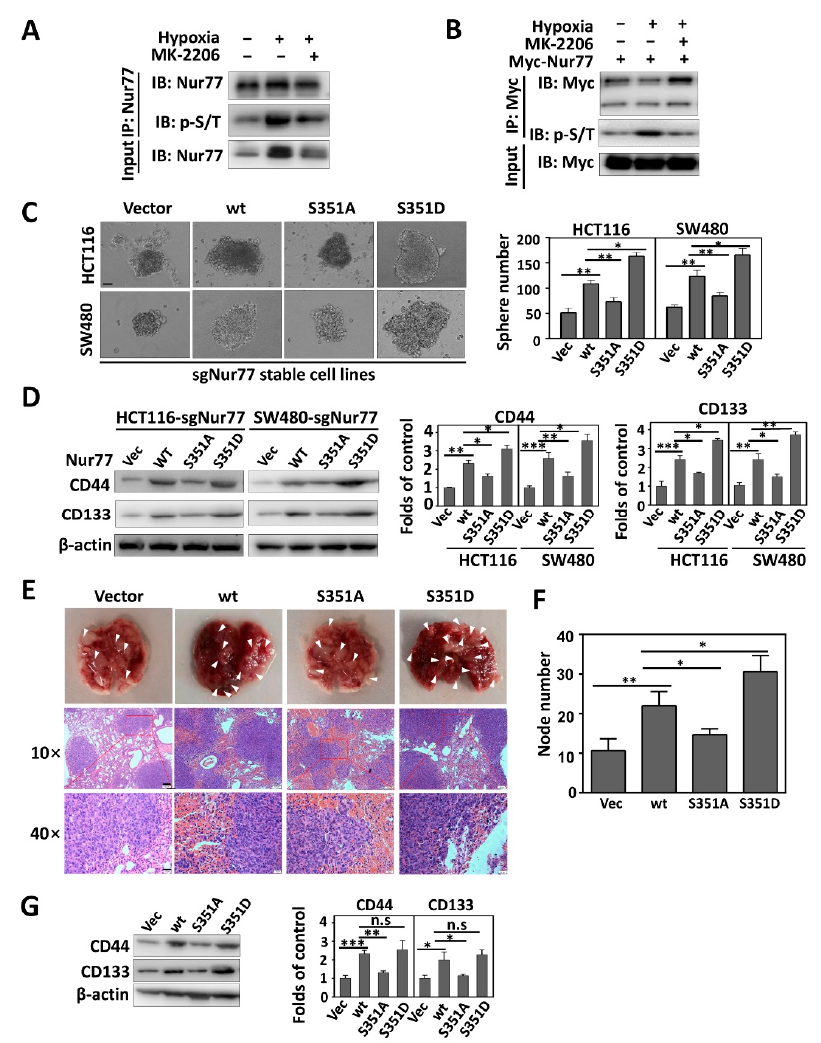
Figure 3. Nur77 is hyper-phosphorylated under a hypoxic microenvironment. ( A , B ) Hypoxic stim- uli. HCT116 and its stable cell line expressing Myc-Nur77 were cultured under normoxia (20% O 2 ) or hypoxia (1% O 2 ), followed by treatment with or without 1 μ M MK-2206 for 4 h. The cells were lysed and immunoprecipitated with anti-Nur77 antibody ( A ) or anti-Myc antibody ( B ) and blotted with p-Ser/Thr (p-S/T) antibody. ( C , D ) Implication of Nur77 phosphorylation in CSC phenotypes. The CRC cells that carried vector, Nur77/wt, or mutant at the phosphorylation site of S351 (S351A or S351D) were cultured as tumor spheres in a 3D environment for 2 weeks; spheres (>50 μ m) were photographed and counted (scale bar, 50 μ m) ( C ). Otherwise, the cells were grown in a normal medium under hypoxia for 24 h ( D ). The effects of Nur77 mutation at S351 on CSC markers (CD44 and CD133) were determined by Western blotting ( D , left). The blot grey intensities were quantified ( D , right). ( E – G ) BALB/c nude mice were subjected to the tail-vein injection of HCT116 Nur77/KO cells stably transfected with vector, Nur77/wt, Nur77/S351A, or Nur77/S351D ( n = 6 per group) and allowed to develop metastatic nodules (about 2 months). Representative metastatic nodules are shown (upper panel). The tumors were also subjected to H&E staining (lower panel). Scale bars: 100 μ m in 10× and 20 μ m in 40×. The white arrows represented the metastatic nodules. ( E ). The numbers of metastatic nodules were statistically analyzed ( F ). Metastatic tissues were lysed and blotted for detecting CD44 and CD133 expression ( G ). * p < 0.05; ** p < 0.01; *** p < 0.001 vs. respective control.